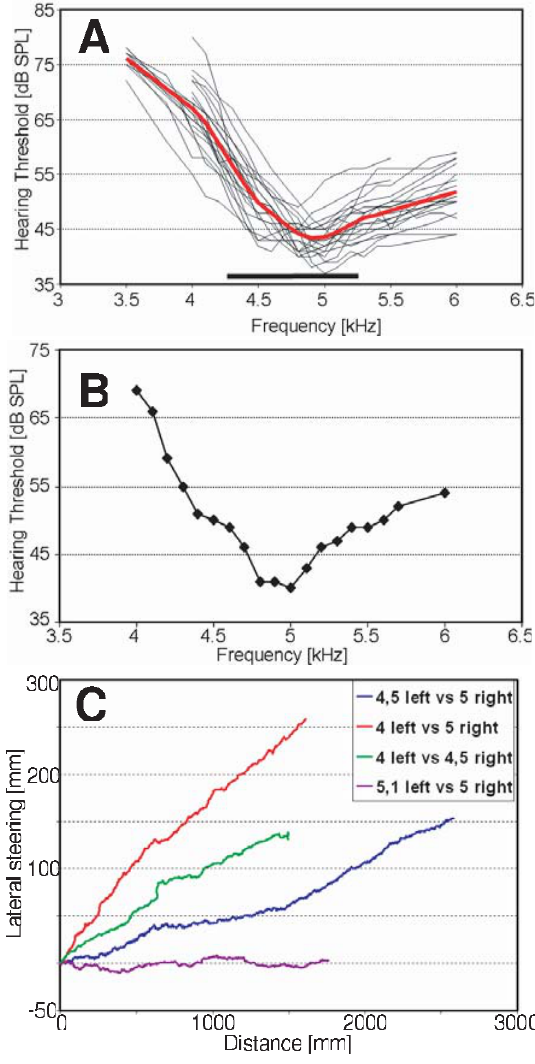
Figure 1. Tuning of AN1-interneuron and its relevance for the preference of females in two-choice tests . (A): Variance of tuning curves (red=average tuning; N=20) in relation to the range of variation of carrier frequencies of male calls (black bar). (B): Tuning of AN1 in a single female and (C) the degree of lateral steering in a two-choice situation towards a calling song at a CF providing the stronger stimulation (right speaker).